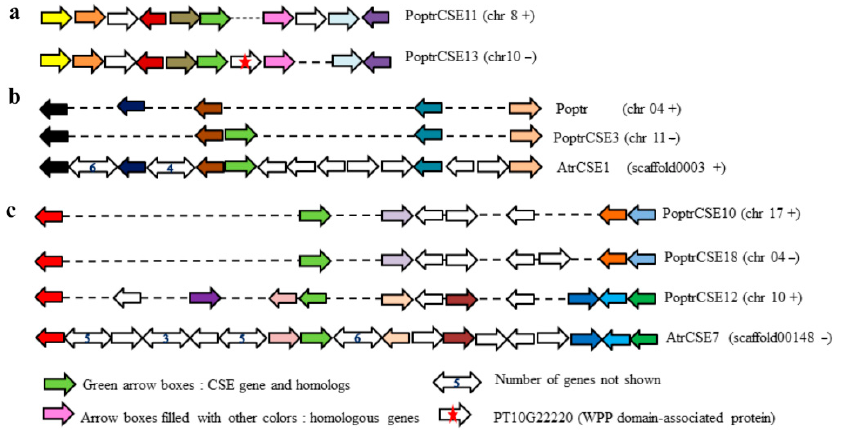
Figure 2. Collinear analysis of homologous segments between Populus and Amborella . The collinear analysis of ( a ) PoptrCSE11 and PoptrCSE13, ( b ) PoptrCSE3 and AtrCSE1 and ( c ) AtrCSE7 , PoptrCSE10, PoptrCSE12 and PoptrCSE18. Green arrow boxes present the CSEs and CSE homologs; arrow boxes filled with other colors indicate other homologous genes (orthologs or paralogs). The symbols of CSE genes and the chromosomes on which they are located are marked on the right. In particular, Poptr (chr 04 +) means no CSE homologs were found on this homologous segment (positive strand) on Populus chromosome 04.